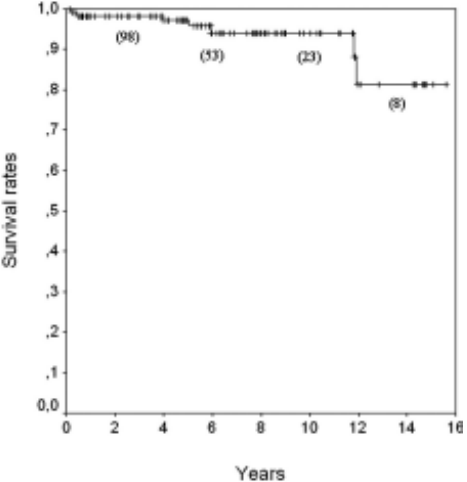
Fig. 4 - Curva de sobrevida actuarial incluindo somente óbitos cardíacos. () indivíduos sob